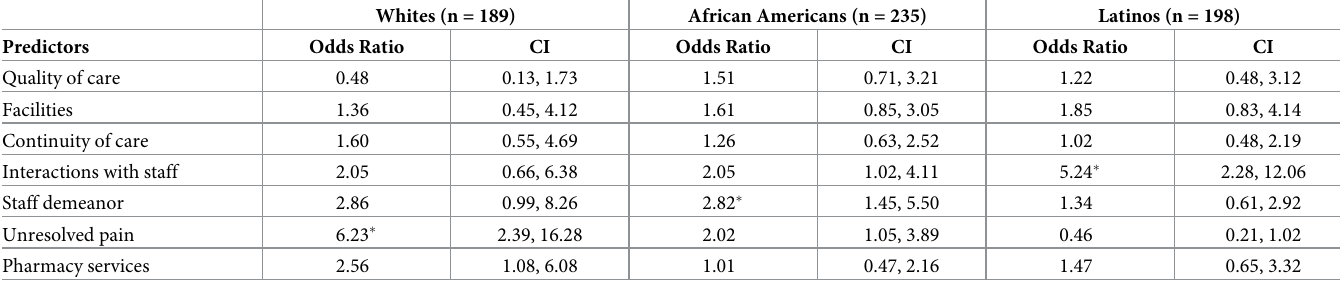
Table 5. Final multivariable models containing dissatisfaction domains associated with any (vs. no) racial/ethnic-based perceived discrimination while seeking healthcare, stratified by racial/ethnic